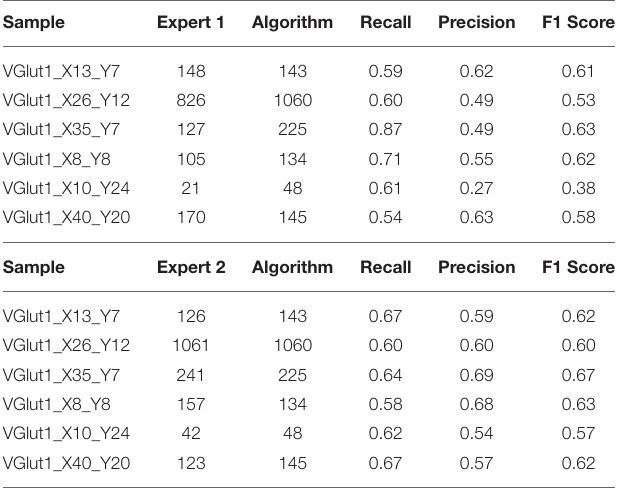
TABLE 2 | Comparison with the two experts, vGlut-1 marker.